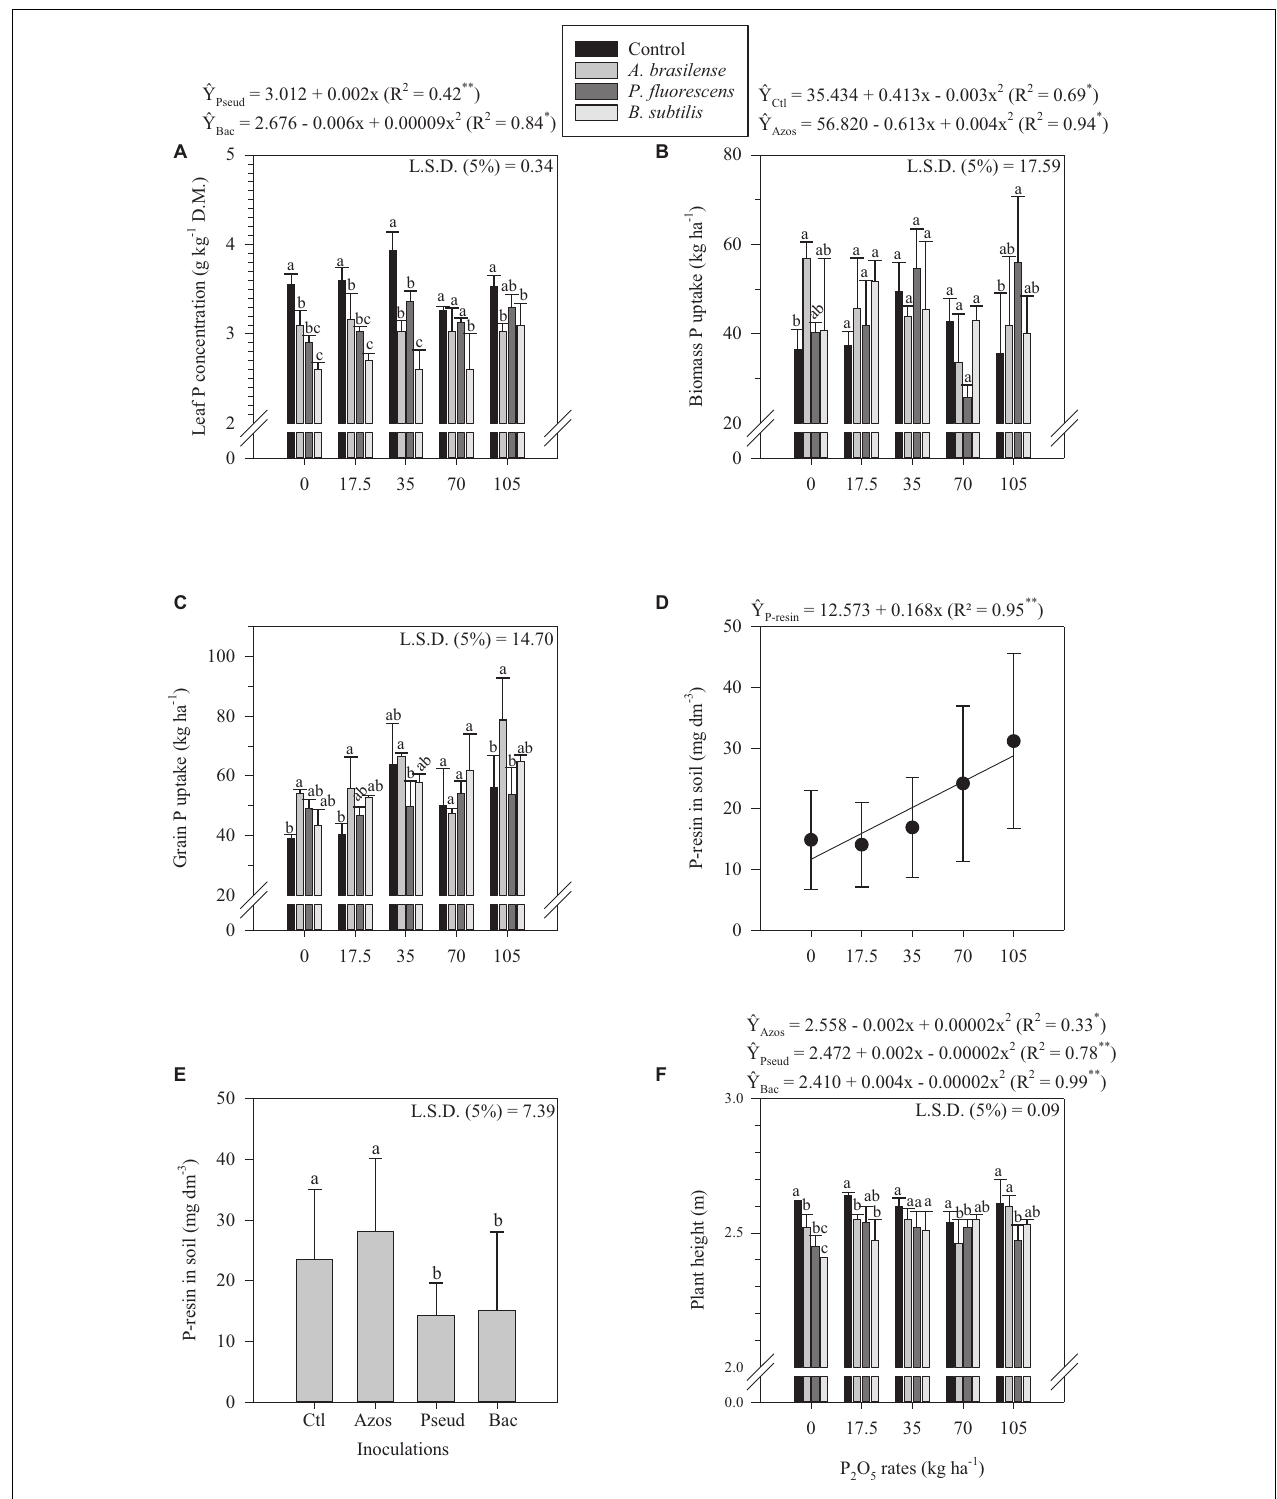
FIGURE 2 | Leaf P concentration (A) , Biomass P uptake (B) , Grain P uptake (C) as a function of the interaction between P 2 O 5 rates and inoculations, P-resin in soil as a function of P 2 O 5 rates (D) and inoculations (E) and plant height (F) as a function of the interaction between P 2 O 5 rates and inoculations in corn crop. The letters correspond to a significant difference at 5% probability level ( p ≤ 0.05). Error bars indicate the standard deviation of the mean ( n = 4). Ctl, Azos, Pseud e Bac refers to the control treatment and inoculations with A. brasilense , P. fluorescens and B. subtilis , respectively. L.S.D. (least significant difference), D.M. (dry matter).